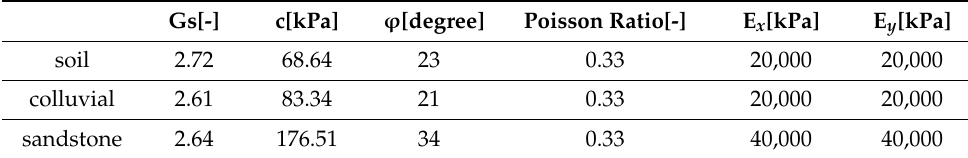
Table 1. Soil mechanical parameters.